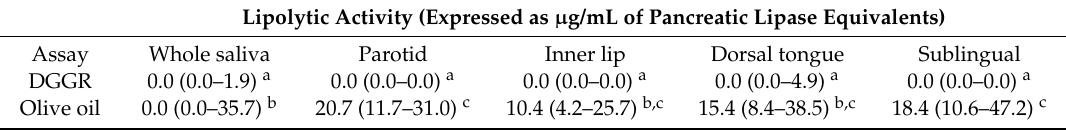
Table 1. Calculated median (interquartile range) lipolytic activity for saliva samples.